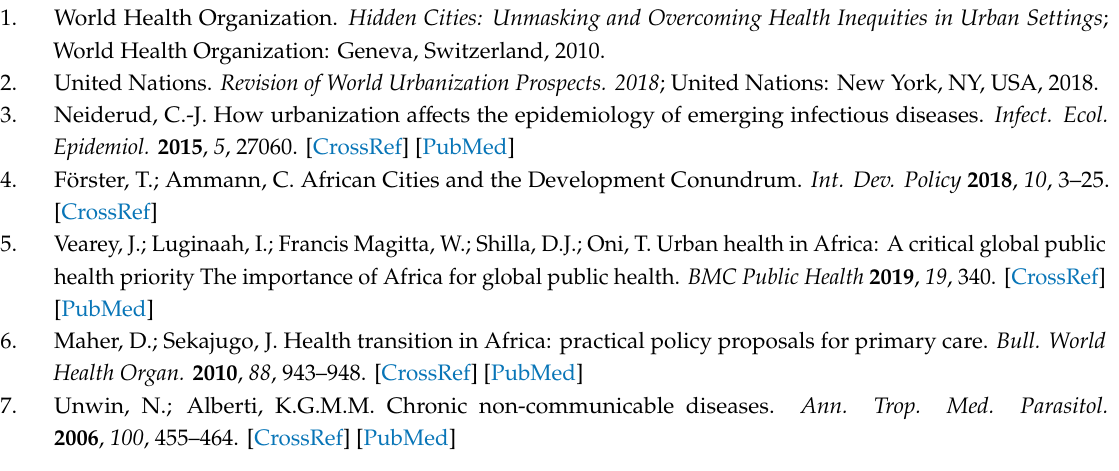
Table S1: Search syntax. Table S2: Full details on the papers identified during the literature review, selection of possibly eligible works, full texts selected for review, and included full texts, describing the urban risk factors for infectious disease (see sequential